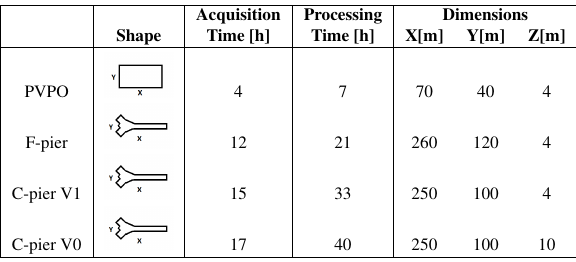
Table 1: Test site